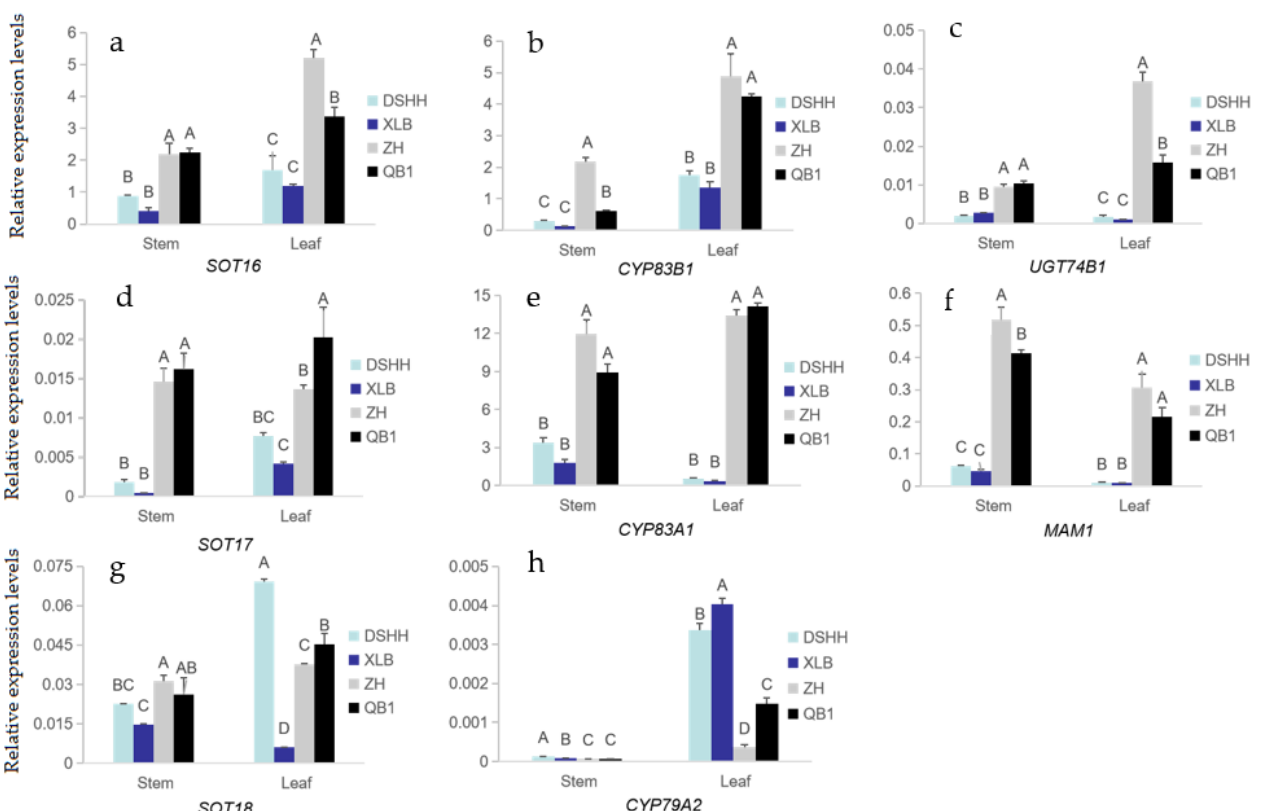
Figure 4. Expression analysis of biosynthetic genes in Chinese kale varieties with different glucosinolate content. ( a – h ) The relative expression levels of 8 genes determined by qRT-PCR. QB1 and ZH Chinese kale varieties with higher glucosinolate content; XLB and DSHH Chinese kale varieties with lower glucosinolate content. Different capital letters indicate extremely significant differences ( p < 0.01).